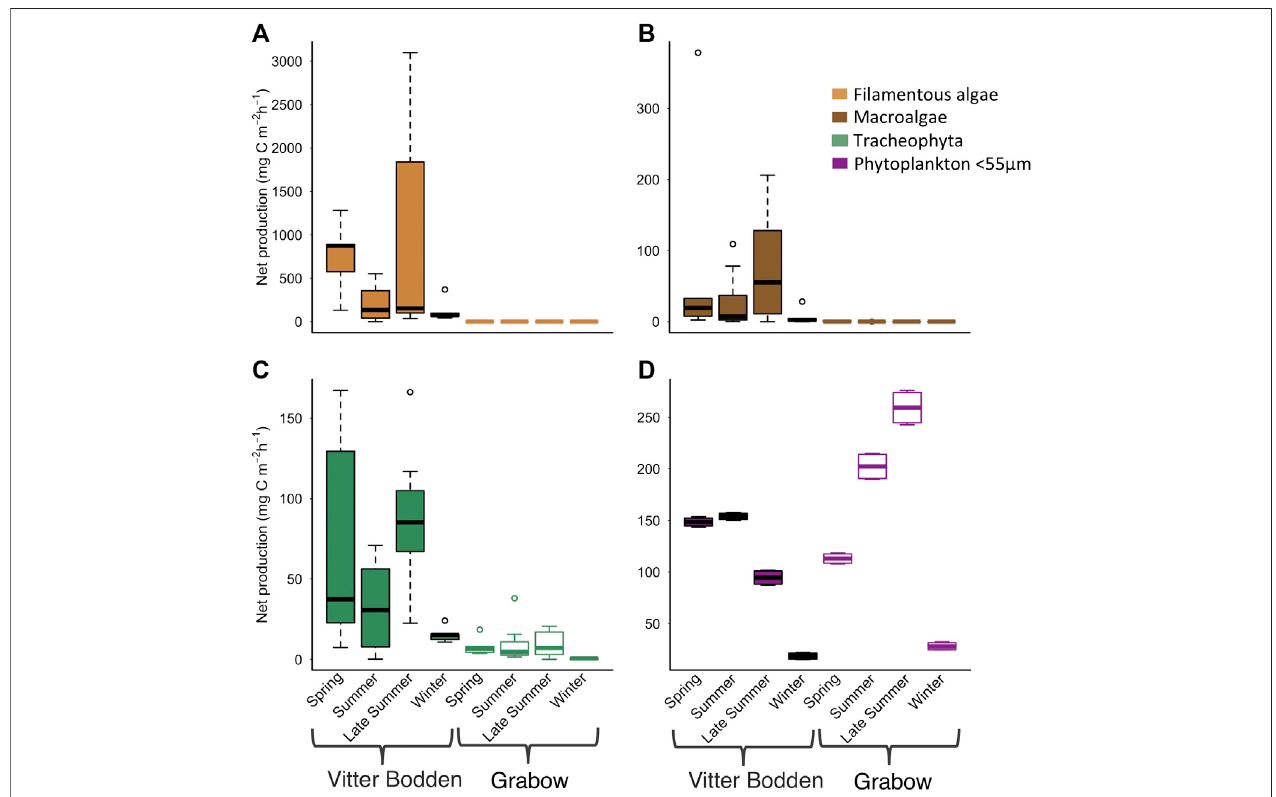
FIGURE 5 | Average hourly daytime primary production for (A) fi lamentous algae (B) macroalgae (C) tracheophyte (D) phytoplankton in Vitter Bodden ( fi lled) and Grabow (open) at sampling occasions. Phytoplankton production was experimentally determined by oxygen evolution in light and dark bottles. The benthic production from fi lamentous algae, tracheophyte and macrophytes was calculated using species speci fi c photosynthesis parameters from the literature combined with own biomass data. Note the different scales.